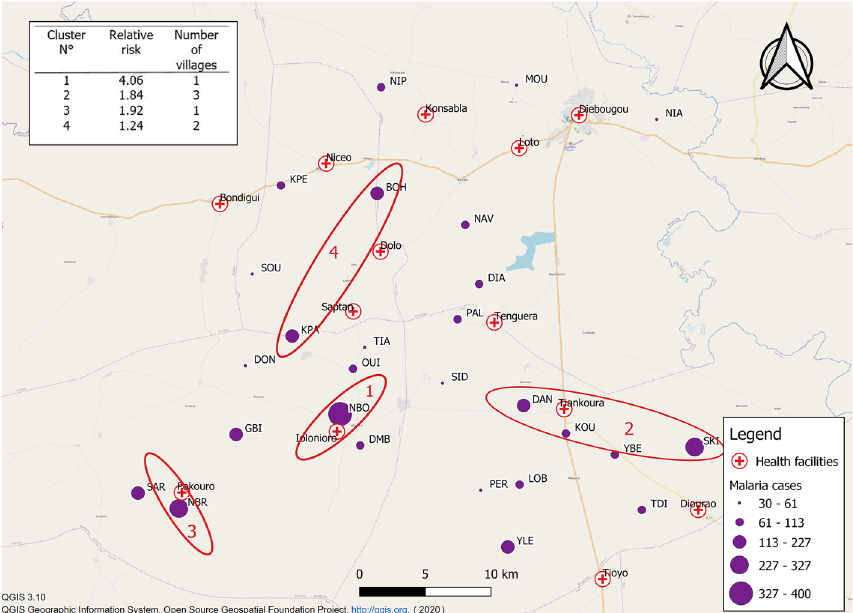
Figure 5. Map of malaria cases detected in 27 villages of Diébougou health district, Burkina Faso, for the epidemic year 2016–2017; hotspots identified with the Kulldorf scanning method. Background: